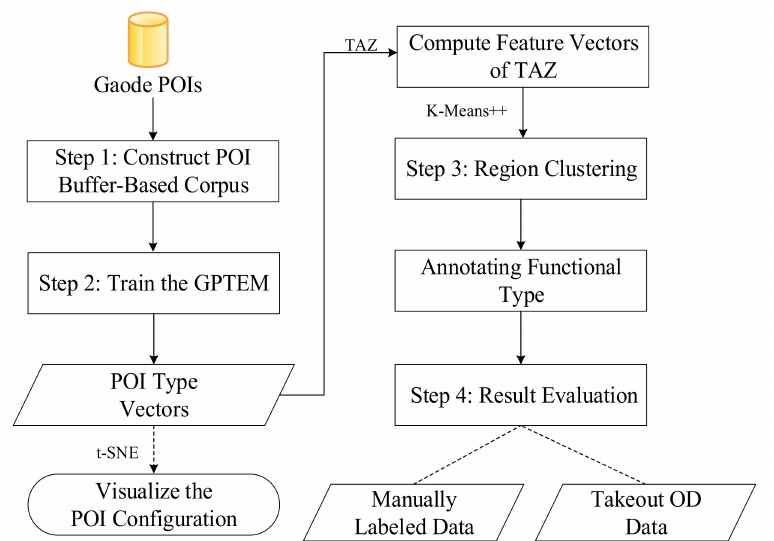
Figure 1. Flowchart of the proposed method in the